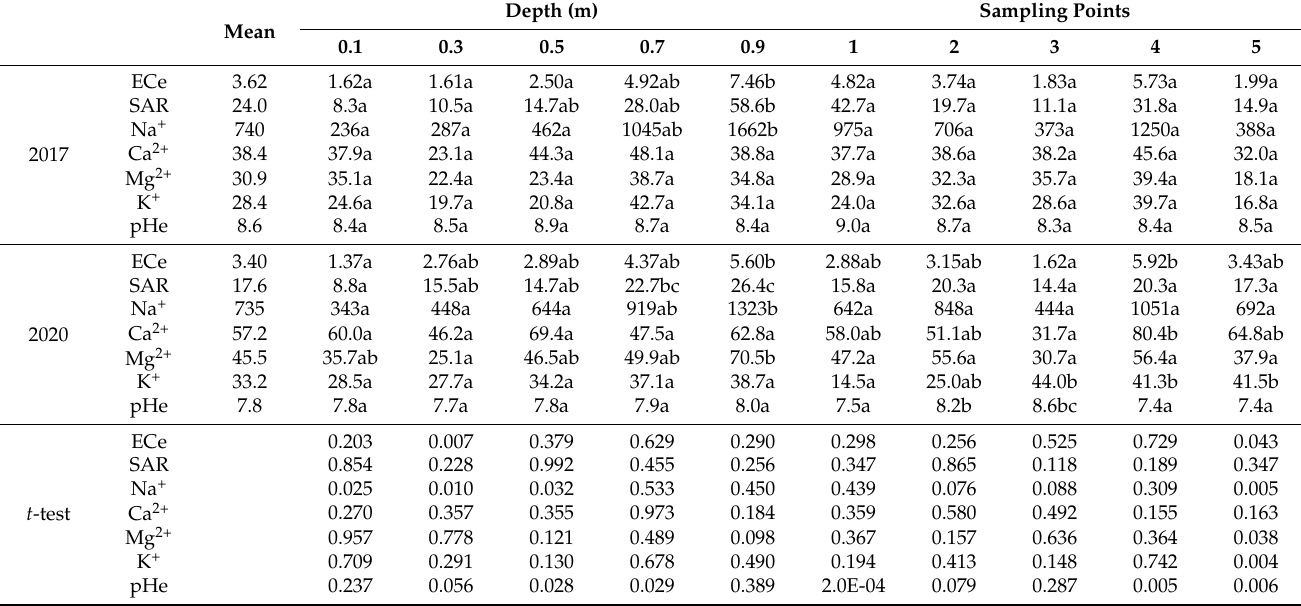
Table 1. Mean soil properties by soil depth and sampling point for soil samples taken in 2017 and 2020. Significant differences (ANOVA) are indicated by different letters ( p < 0.05). Significance of the differences between 2017 and 2020 (Student’s t -test) are shown in the lower panel. ECe and SAR are in dS m − 1 and mmol c1/2 L − 3/2 , respectively, while ion concentrations are in mmol c L − 1